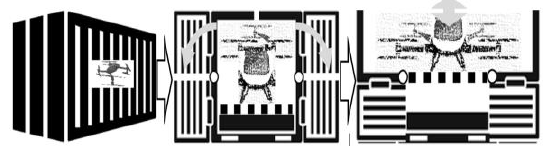
Figure 15. Passenger UAV transportation & deployment stages, using a standardized container box, which converts to a docking hub